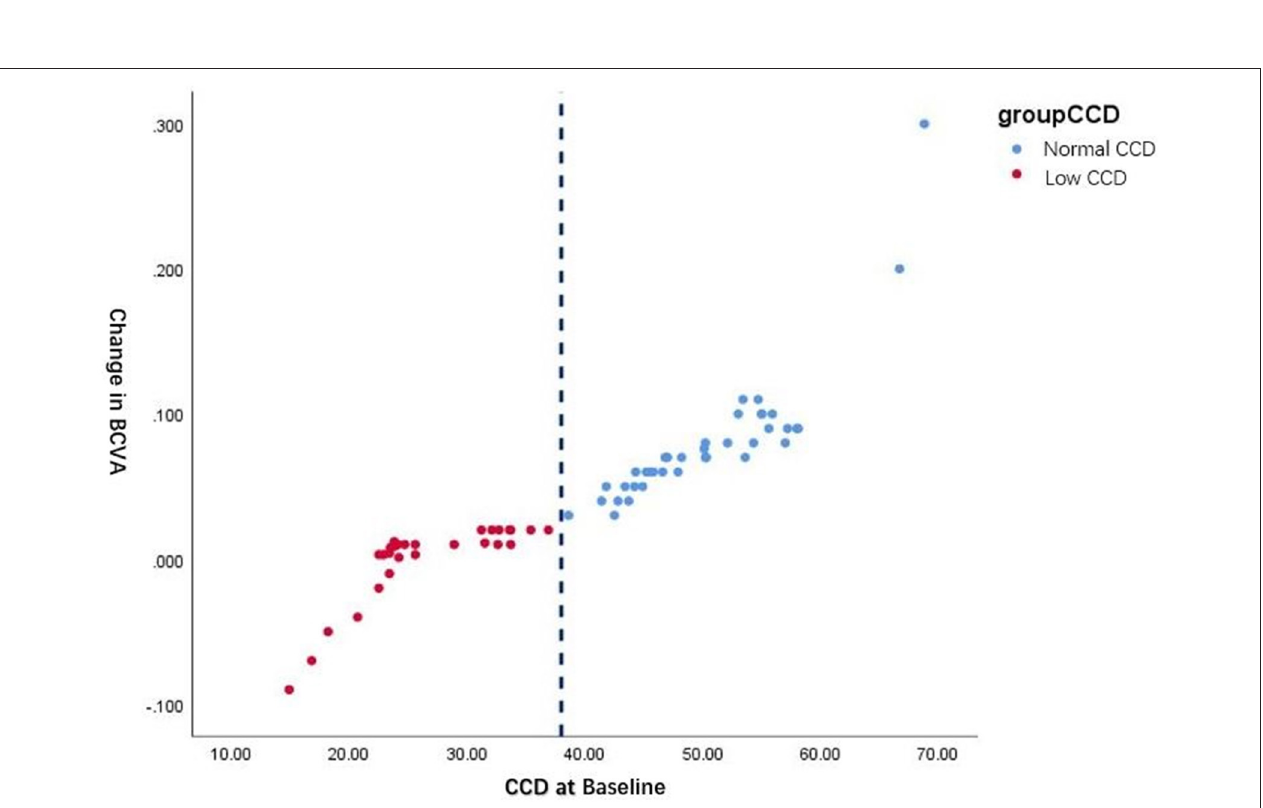
FIGURE 3 | Comparison of the BCVA changes from pre-operative to post-operative assessment among eyes in the low and normal CCD group.